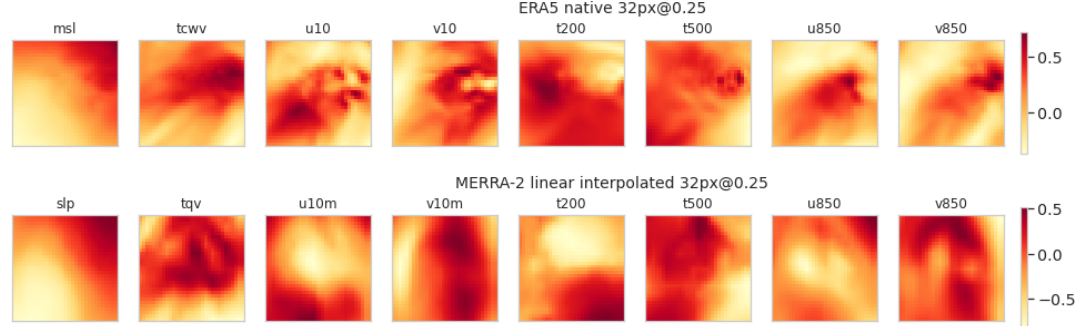
Figure 11. Channels of the image on 6 August 1990, 06:00UTC, centered on 27 ◦ N, 46.875 ◦ W, taken as an example of a wrongly classified image as background (false negative). Data are standardized.